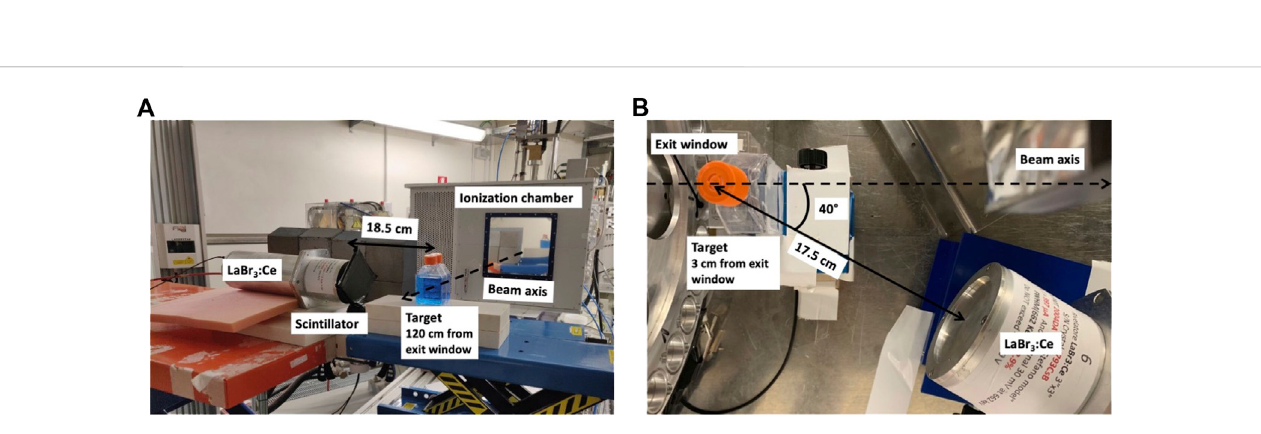
FIGURE 2 Pictures of the experimental setups used at TPC (A) and at the Cyrcé facility of Strasbourg (B) . In the images, the liquid targets are displayed. The solid targets were placed at the same positions, and suspended in air with a thin plastic wire. All distances were measured from the target center and the LaBr 3 :Ce surface, and are reported in